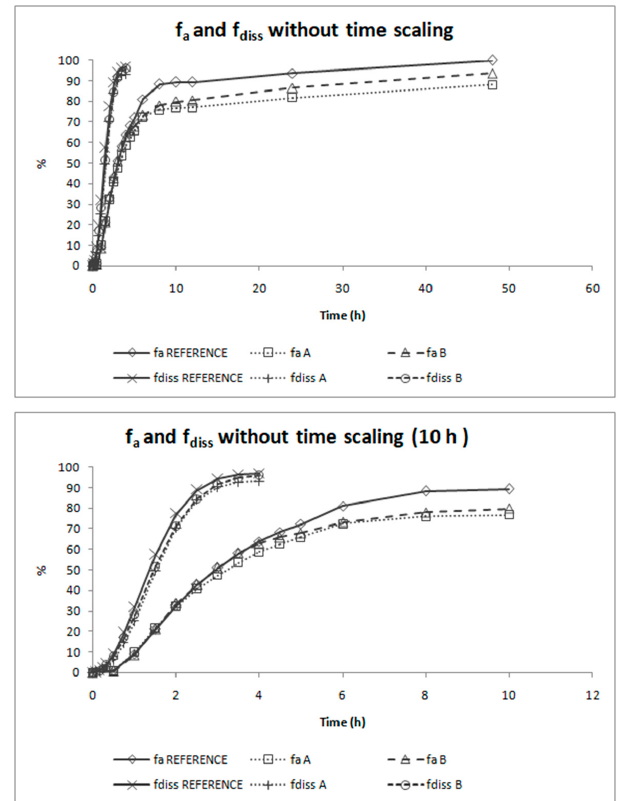
Figure 6. Absorption and dissolution profiles of the three products of candesartan cilexetil (Reference, Product A and Product B) represented together in the real time scale. The first panel shows the complete profiles and the second one is limited to time equal to 10 h. f a = fraction absorbed, f diss = fraction dissolved. Table 4. Characteristics of the dissolution experiments conducted in USP IV (Dissolution media, flow rate and sampling